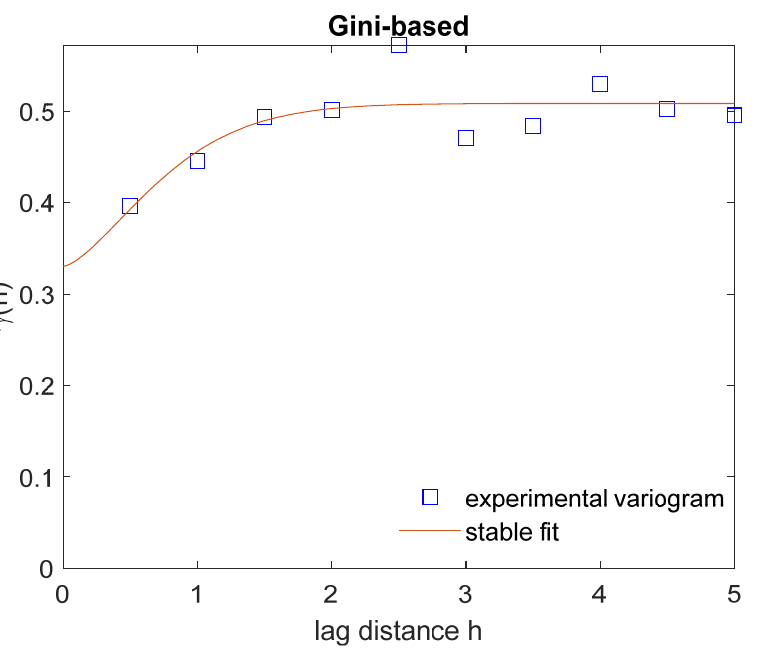
Figure 6. Experimental variogram (blue squares) based on the Gini index for 70 measurement points that were modelled by a stable function (red line).